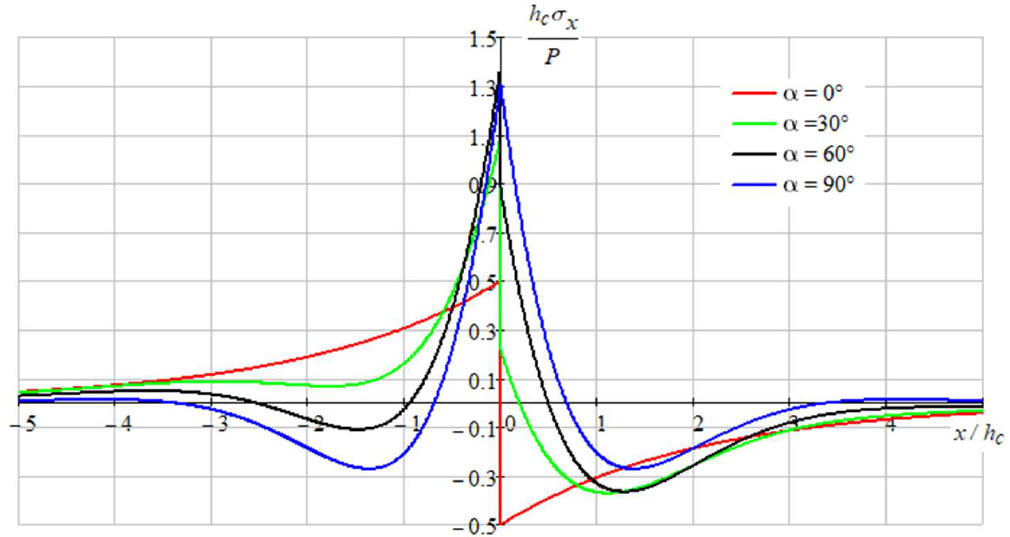
Figure 9. Distribution of normal stresses σ x in the coating at the boundary of contacts between the layers ( y = h c ).